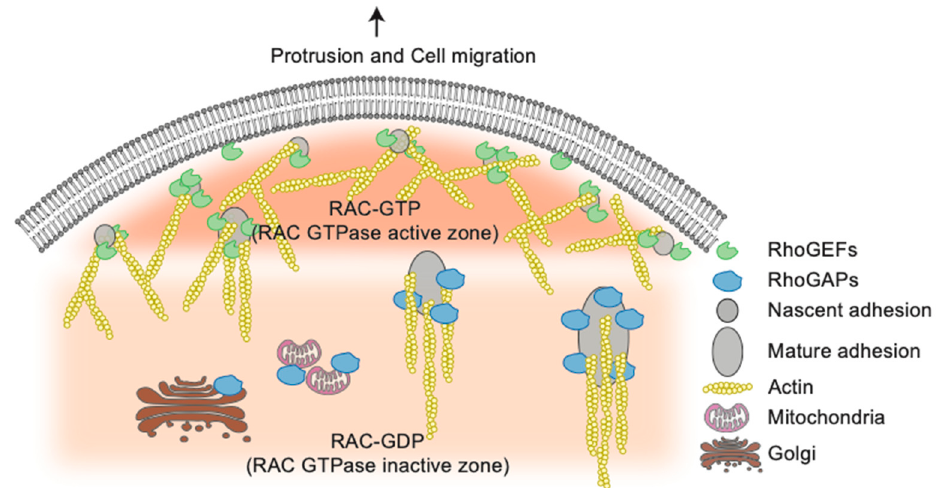
Figure 4. The spatial distribution of Rho GTPases by their regulators the RhoGEFs and RhoGAPs determines Rho GTPase activity. Schematic representation showing that the spatial distribution of RhoGEFs and RhoGAPs helps to create Rho GTPases active and inactive zones in cells The Golgi and mitochondria only host RhoGAPs. This could allow the inactivation of Rho GTPases that would have di ff used away from their desired site of